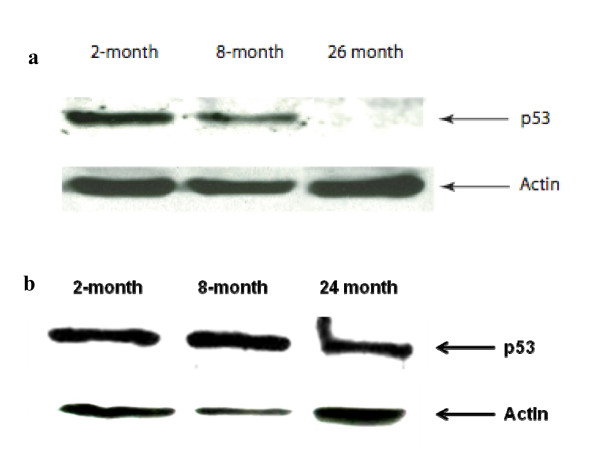
Western blot of p53 expression.  (a) Cell lysates from each age group were analyzed by western blot as described in Methods.  Consistent with microarray and RT-PCR analysis, MSCs derived from 26-month mice did not express the p53 protein.  (B) Spleen lysates from progressively aged mice showed no change of p53 protein.